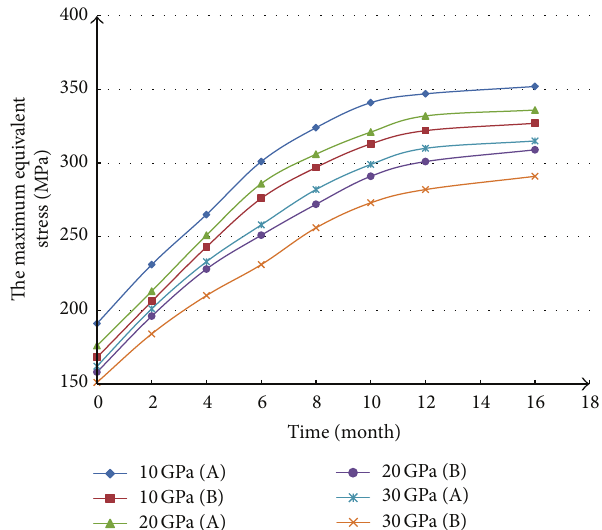
Figure 4: Relationship between the elasticity modulus of mudstone interbed and the equivalent stress on casing. (A) The casing equivalent stress in the middle of salt rock. (B) The casing equivalent stress in the middle of mudstone